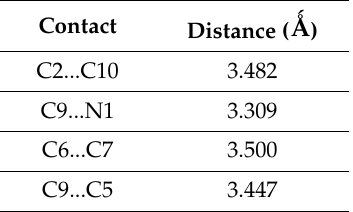
Figure 5. Shape index map showing the shortest π - π interactions. Table 3. Contact distances of the most significant π - π interactions. Table 3. Contact distances of the most significant π - π